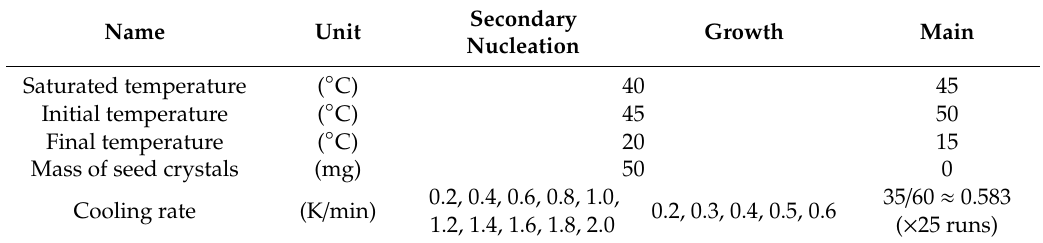
Table 4. Operating conditions of the preliminary experiments for the secondary nucleation and growth kinetics and the main experiments.